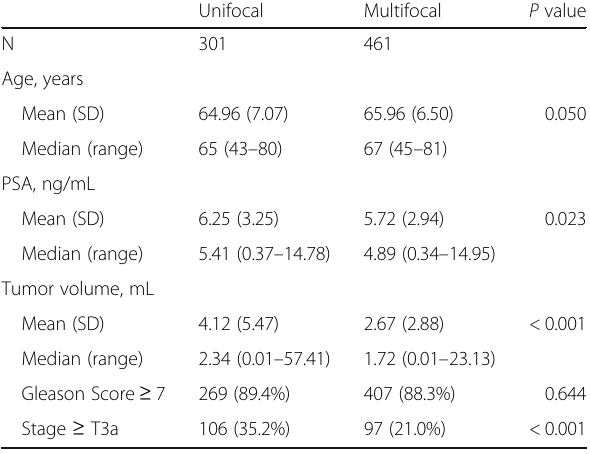
Table 4 Comparison between unifocal and multifocal tumors